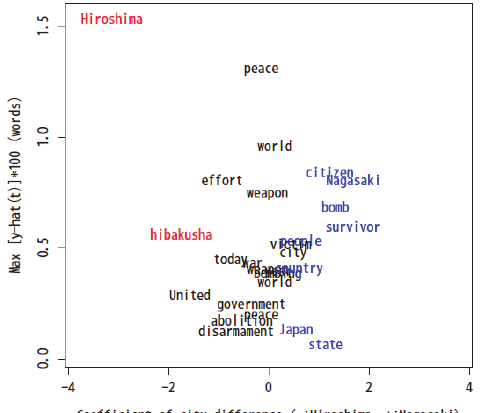
Fig. 11. Scatter plot of keyword's frequency by cluster in 2007